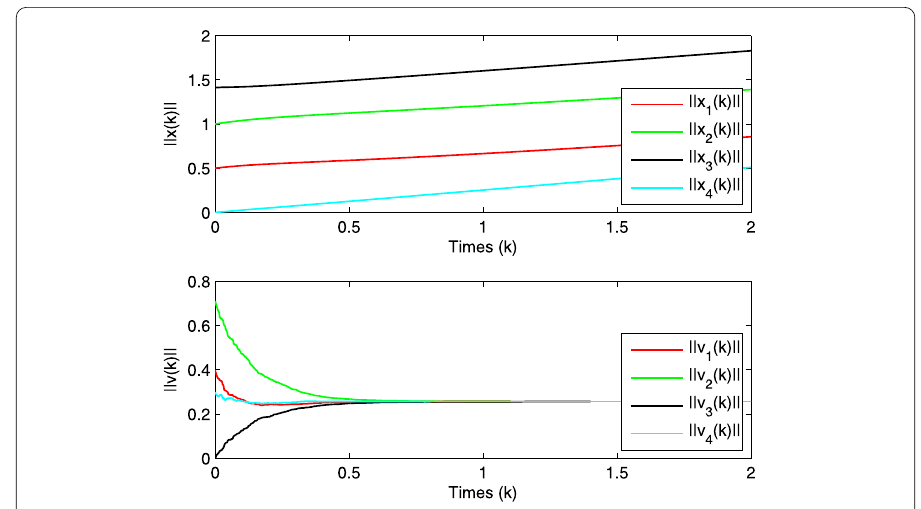
Figure 7 The norms of position and velocity trajectories with α = 1.2 in Case 2